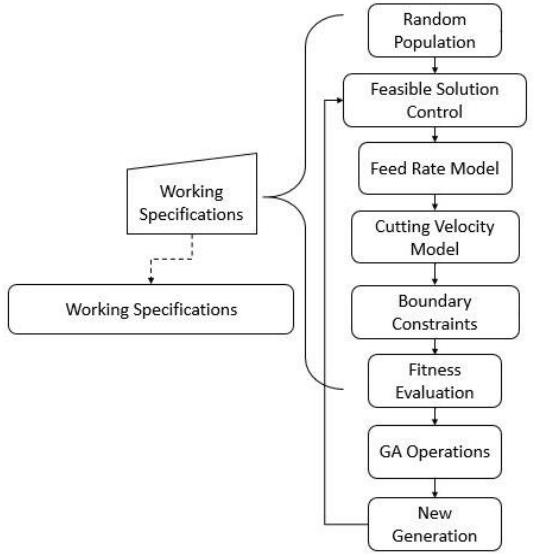
Figure 9. Flowchart of the GA implementation.